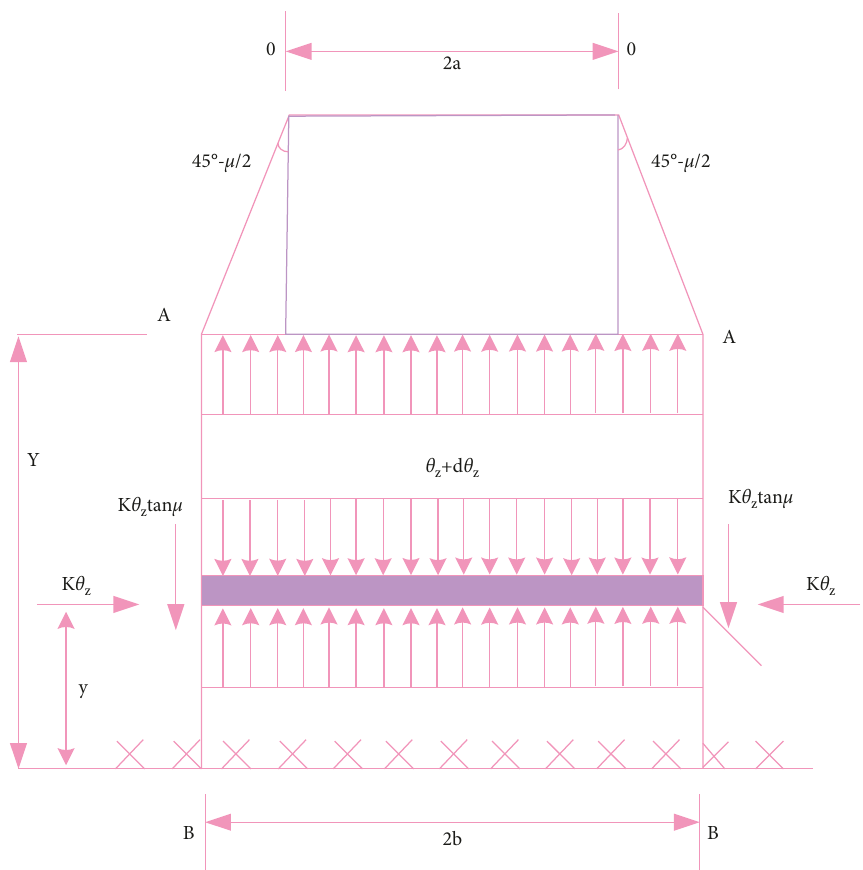
Figure 2: Calculation diagram of surrounding rock